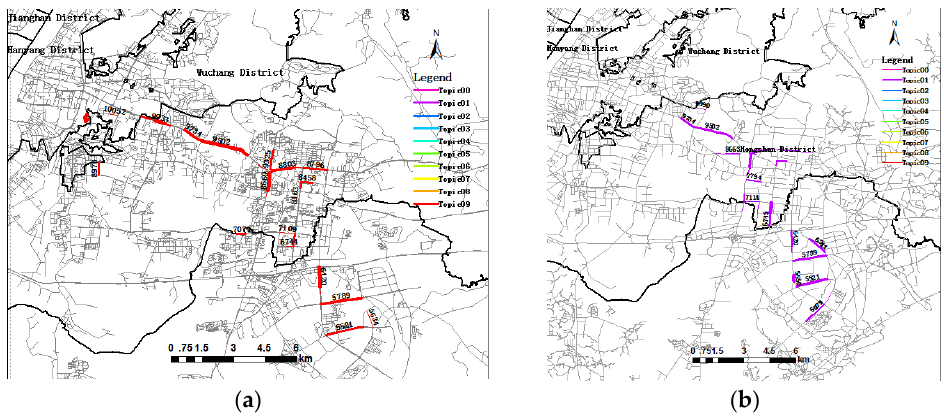
Figure 12. ( a ) Visualization of trip Topic09 during the morning rush hour; ( b ) visualization of trip